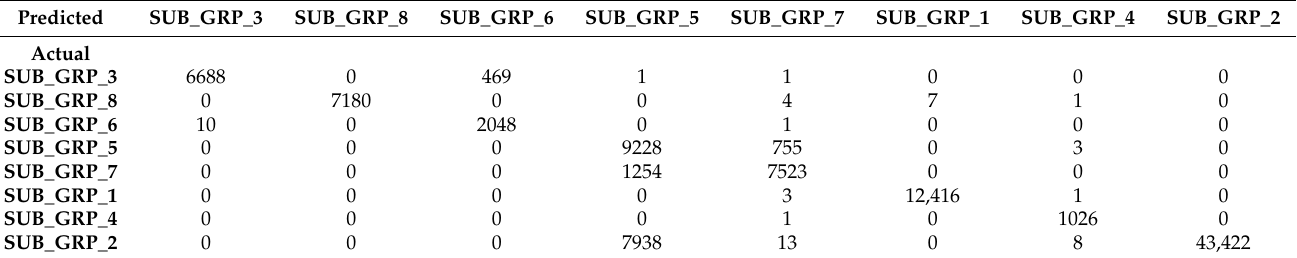
Table 5. Confusion matrix in sub route